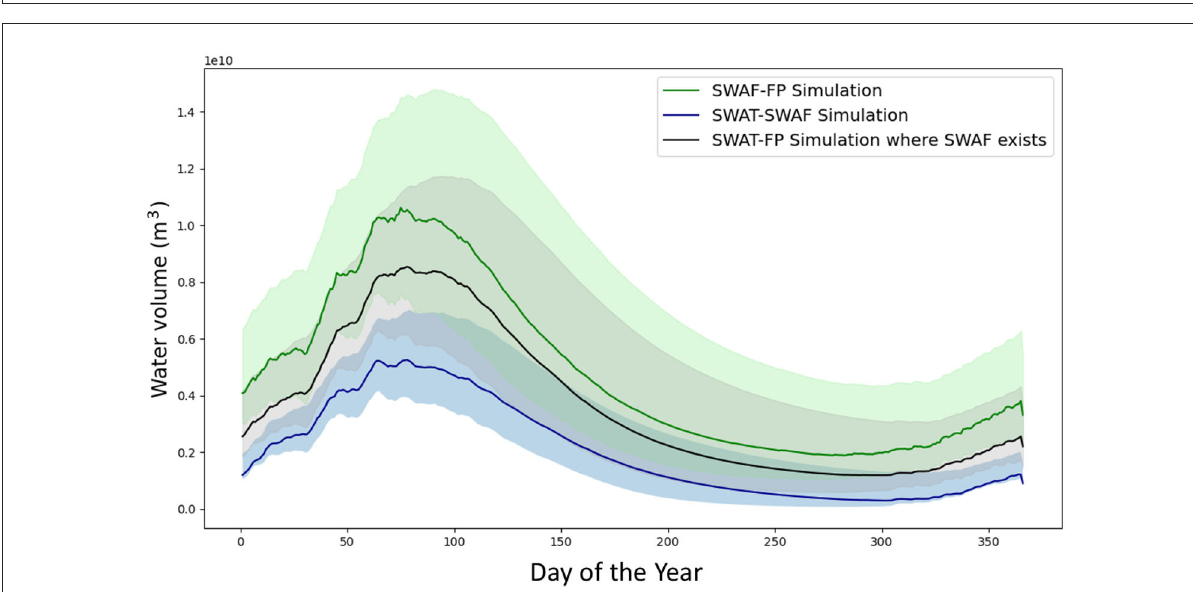
FIGURE6 Average daily water storage in the floodplains of the Madeira Basin for the SWAT-FP model (green), the SWAT-SWAF model (blue). The gray color refers to the extraction of the volumes for the SWAT-FP model on the locations where SWAF